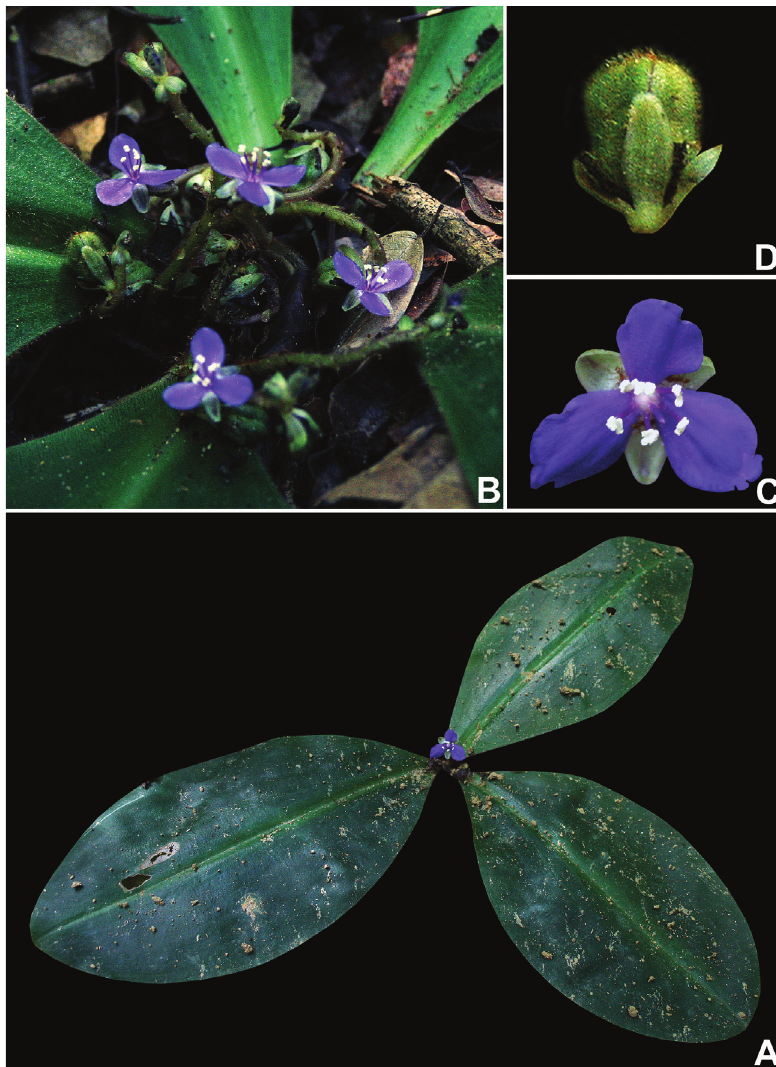
Figure 9. Siderasis medusoides M.Pell. & Faden. A habit, showing a fertile rosette B detail of the synflo- rescence, showing the elongated and tangled cincinni C front view of a flower, showing small ants near the flower center D detail of the capsule. Photographs by P.